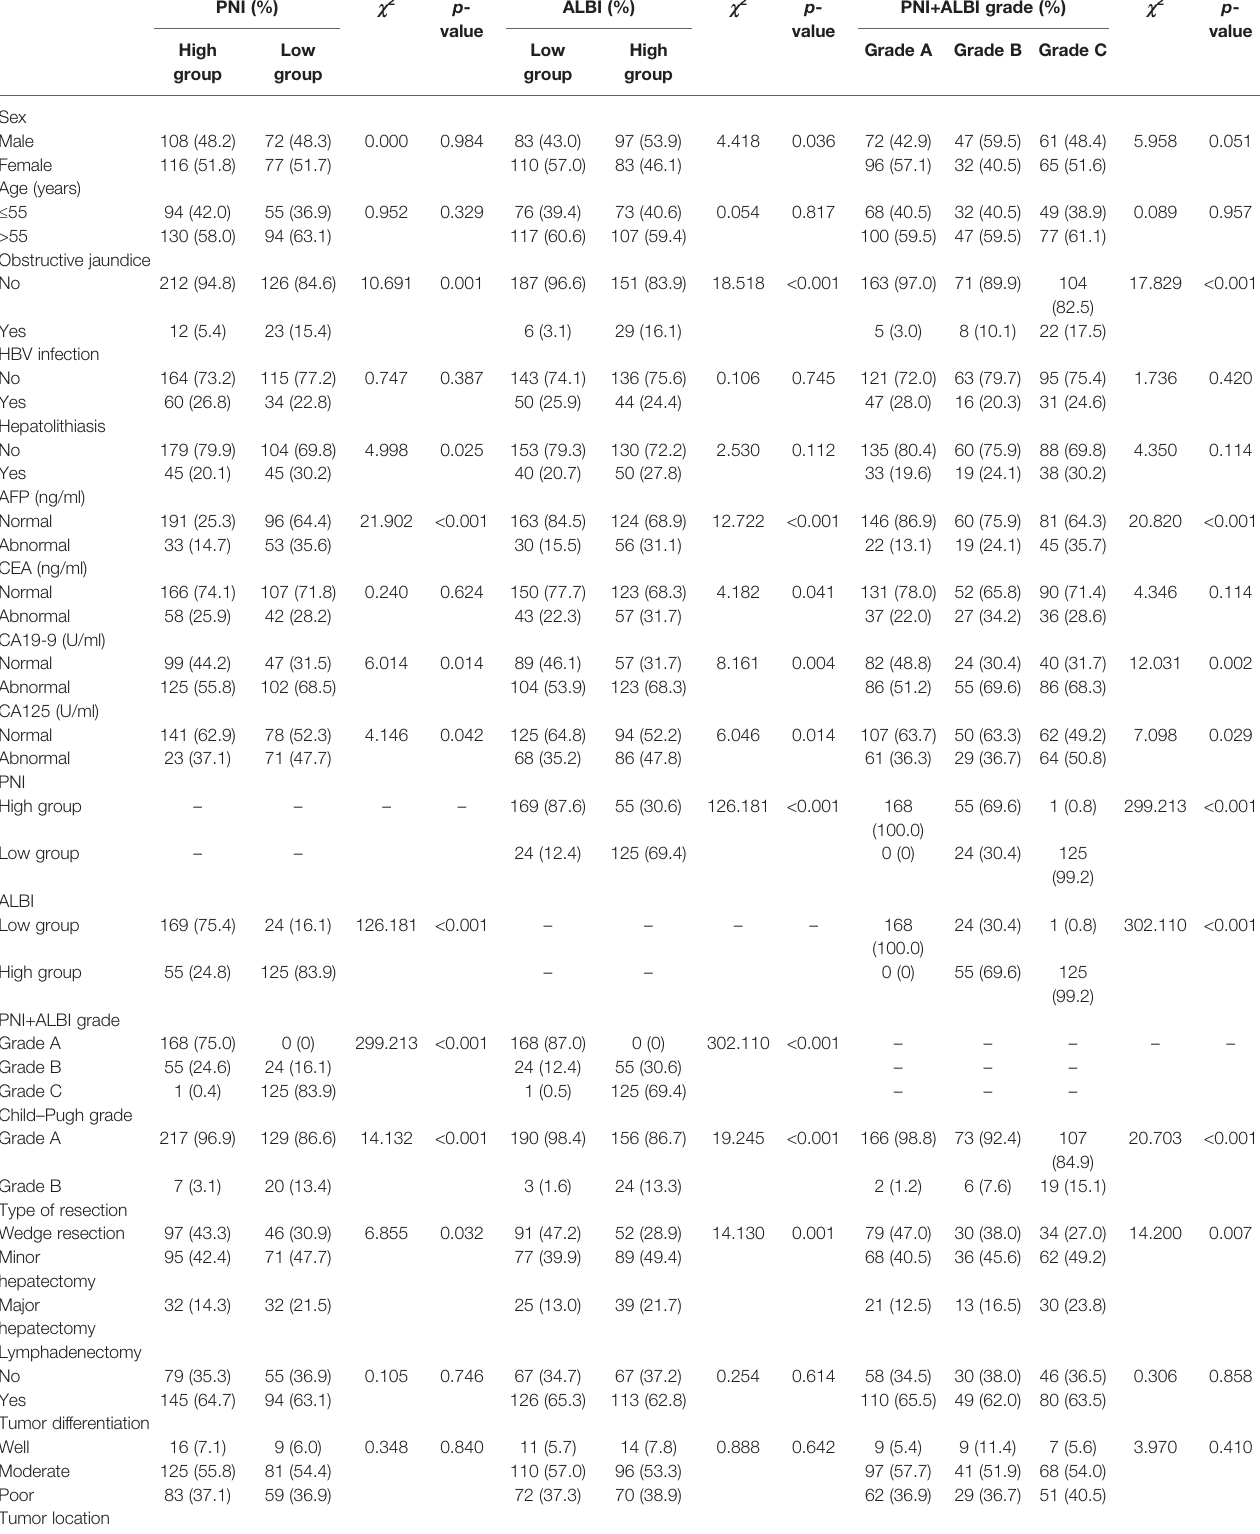
TABLE 2 | Relationship of PNI and ALBI with clinicopathological characteristics of intrahepatic cholangiocarcinoma (ICC) after radical